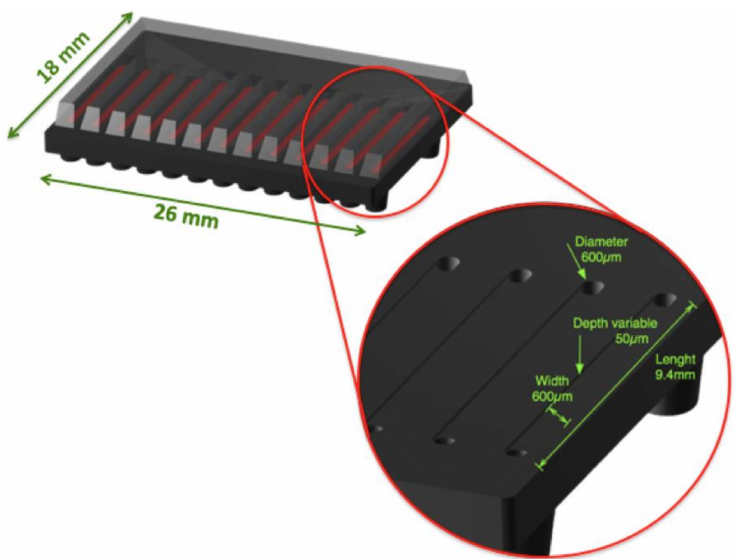
Figure 1. The PMMA 13-channel chip. The dimensions of the whole chip are shown (18 × 26 mm). In the exploded picture of the black bottom part, the dimensions of a single microchannel (50 µ m high, 600 µ m wide, and 9.4 mm long) are indicated. The red lines indicate the location of the microchannels.